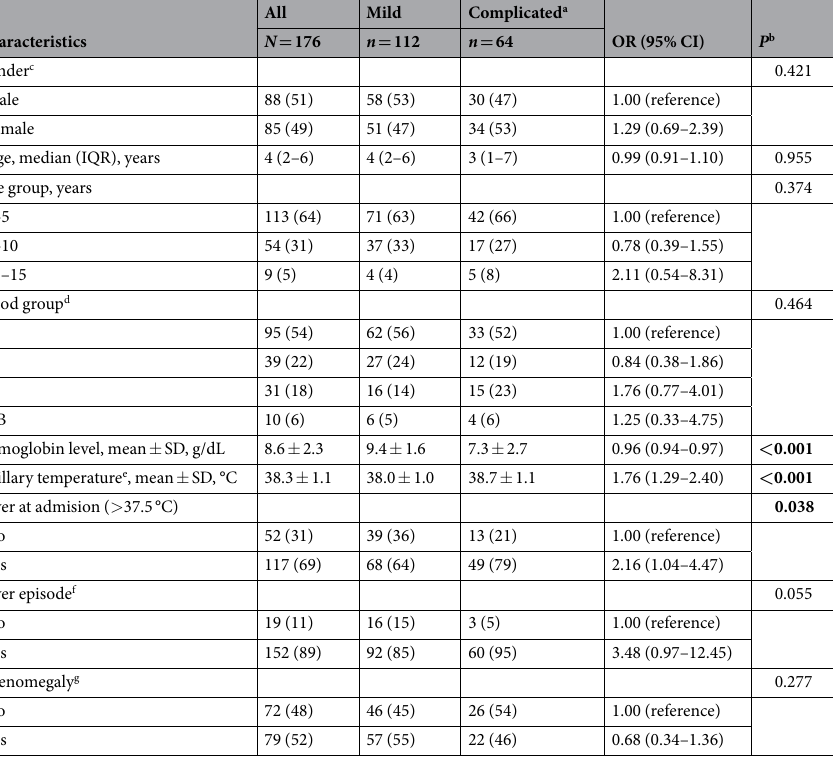
Table 1. Clinical characteristics of children with mild and complicated malaria. Data are number or proportion (%) of patients, unless otherwise indicated. Boldface type indicates statistical significance. a Complicated malaria syndrome; severe malaria ( n = 20), severe respiratory syndrome ( n = 5), cerebral malaria ( n = 5), and complicated ( n = 34). b A conditional logistic regression model was used to calculate the prospective odds of developing complicated malaria. c 3 Missing values. d 1 Missing value. e 7 Missing values. f Fever during the last 24 hours before presenting at the health facility. g 25 Missing